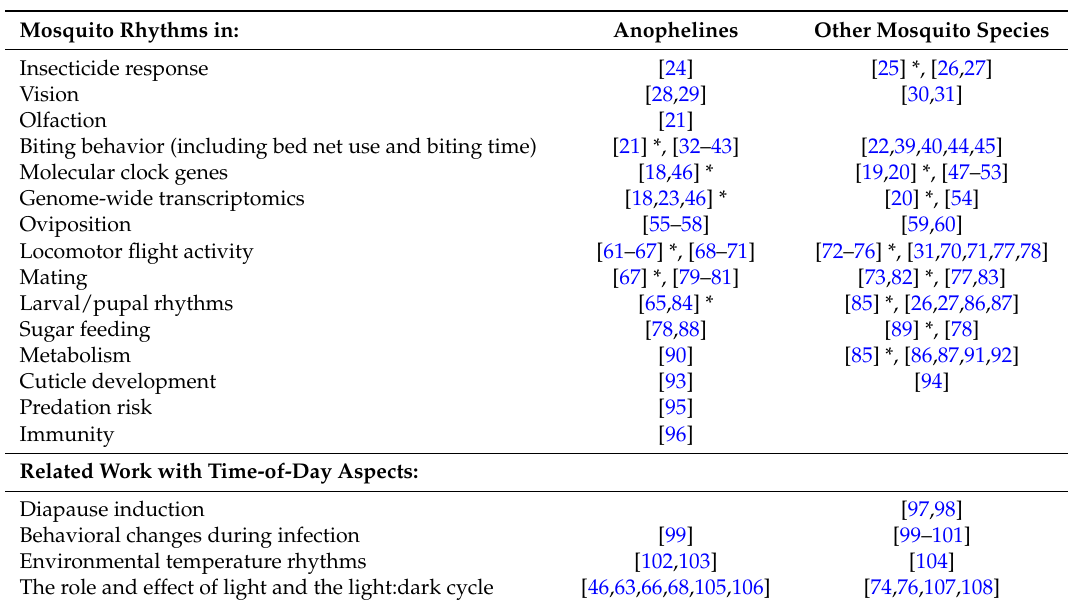
Figure 1. Some of the environmental rhythms a mosquito may be exposed to across the 24-h day. These include physical environmental changes, such as ambient light, UV radiation, temperature and humidity. Mosquitoes also experience the biological rhythms of their hosts, such as when humans are inside or outside of their dwelling, under or not under a bed net and awake or resting (only alert hosts display defensive behavior); and rhythms in predators, such as dragonflies (diurnal) or bats (nocturnal). Parasites may also have rhythms in the activities they undertake in mosquitoes that impact mosquito fitness. Table 1. Time-of-day affects many aspects of mosquito biology.